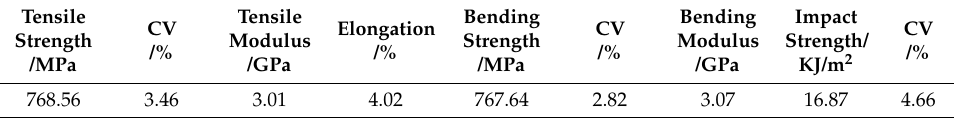
Table 2. Mechanical properties of resin casting body.